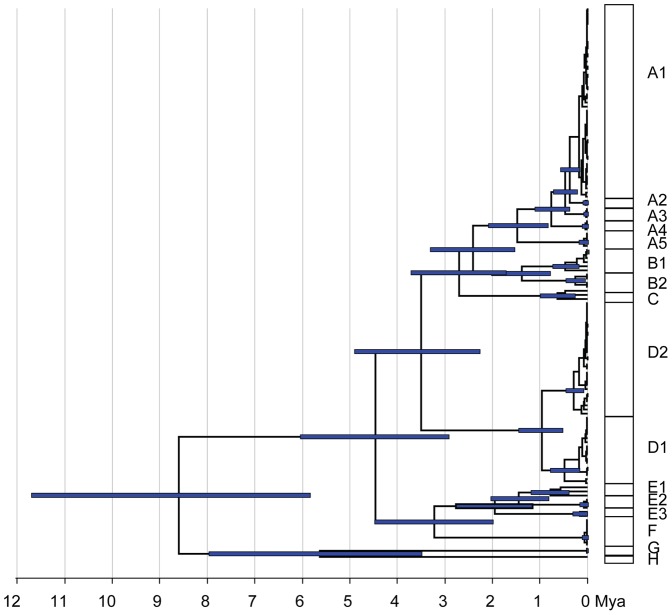
Maximum clade credibility chronogram of the Cyt b dataset.It was derived from an analysis in BEAST using the GTR+I+G model and a relaxed clock. Node bars indicate 95% HPD age ranges.